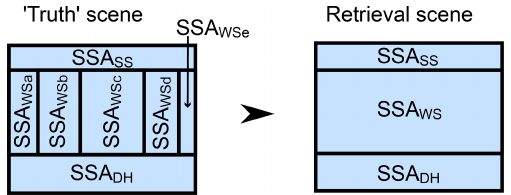
Figure 3. Illustration of three-layer (SS: surface snow; WS: wind slab; DH: depth hoar) truth scene with spatial variability in spe- cific surface area of WS (SSA WSa to SSA WSe ) and the retrieval scene with horizontally uniform SSA. Spatial distribution in truth SSA given by observed spatial distribution at TVC over two win- ters (2013 and 2018).